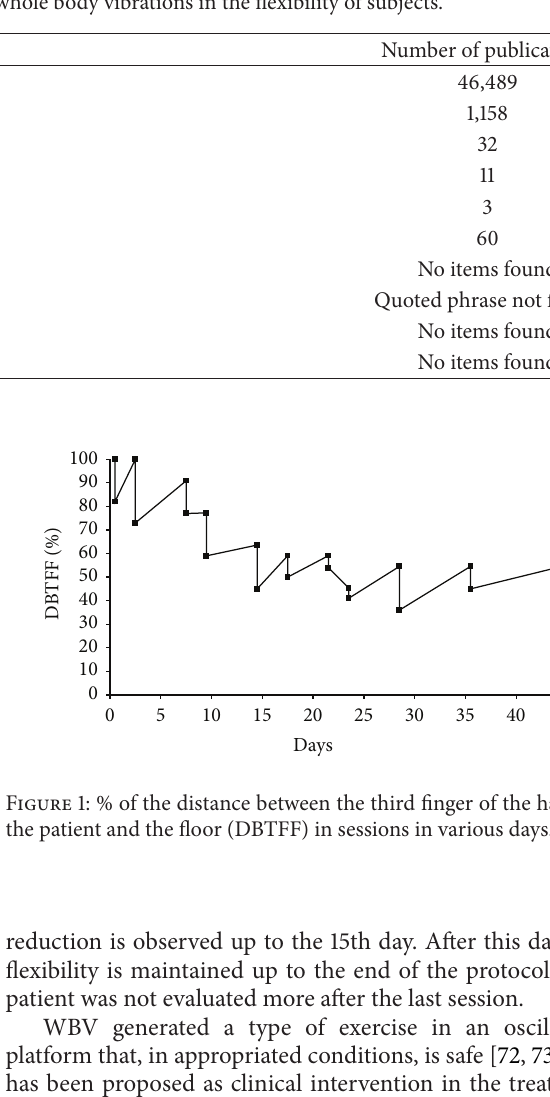
Table 1: Number of publications studying the use of whole body vibrations in the flexibility of subjects.